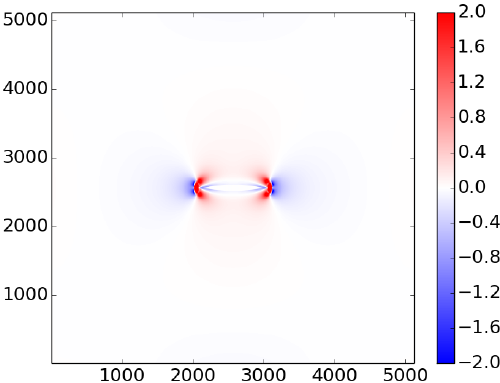
Figure 6. Pressure field with P ∗ = 27.5kNm − 2 minus the pressure field with P ∗ = 20.0kNm − 2 (kNm − 1 ). For both experiments, the thickness field is 2m everywhere except a 1km long, 10m wide horizontal lead in the middle of the domain. The normal stresses at the boundaries are − 10kNm − 1